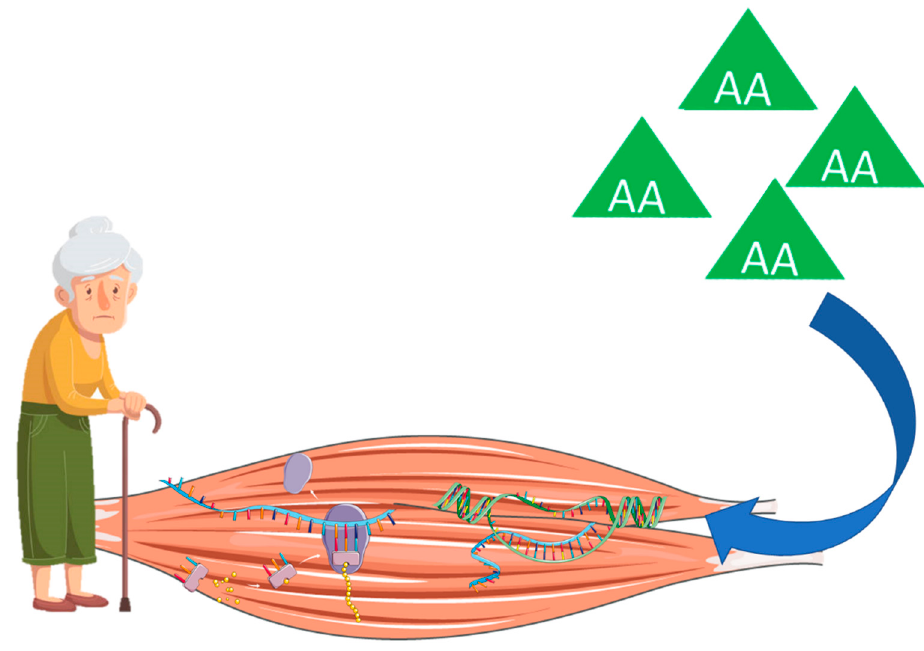
Figure 2. Anabolic resistance to protein intake in older adults. Abbreviation: AA amino acid.